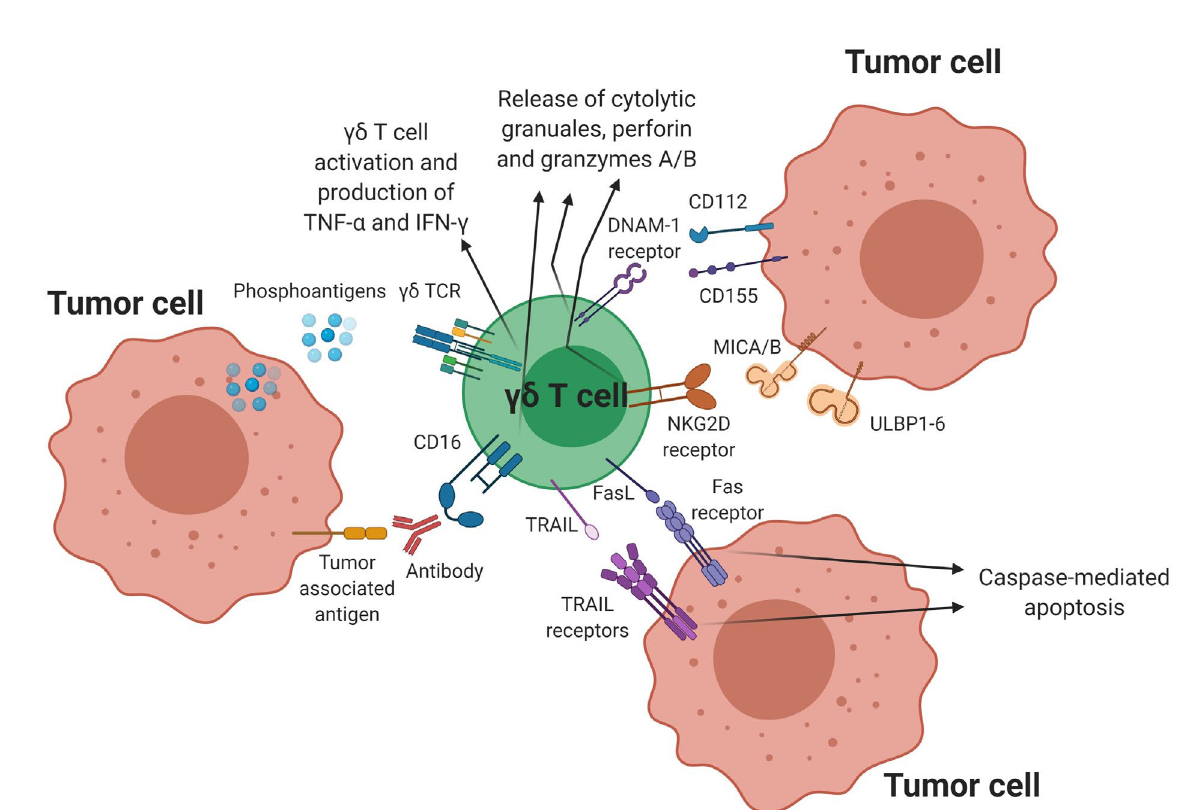
Figure 1. γδ T cell-mediated cytotoxicity against tumor cells. γδ T cells have several direct cytotoxic mechanisms against tumor cells as shown above. Binding of the pAg to the γδ TCR triggers activation resulting in target cell lysis and also stimulates the release of TNF-α and IFN-γ, which enhances the anti-tumor activity of other immune cells. Additional cytotoxic mechanisms include ADCC through CD16 expression, NKG2D and DNAM-1 receptor-ligand interactions as well as the activation of the TRAIL-TRAIL receptor and FasL-Fas receptor